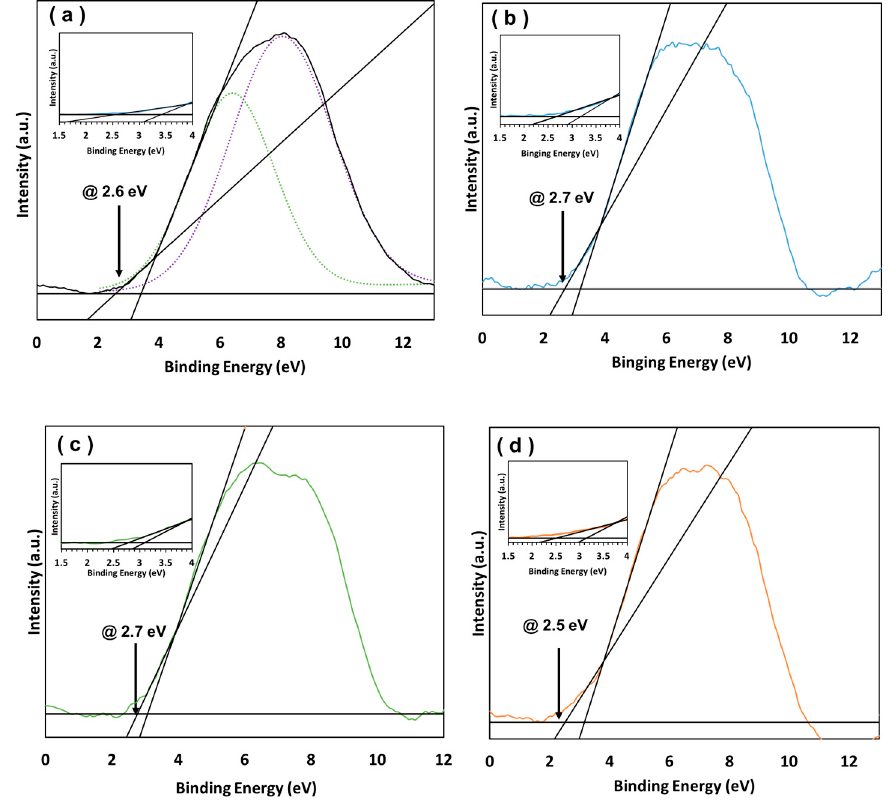
Figure 3. XPS spectra and valence-band maxima of the Nb-doped TiO 2 with Nb contents of ( a ) 0, ( b ) 1.5, ( c ) 3.0 mol %, and ( d ) 5.0 mol %. The Gaussian fitted electron emissions from the π (green) and σ (purple) O 2p orbitals are also shown in ( a ).